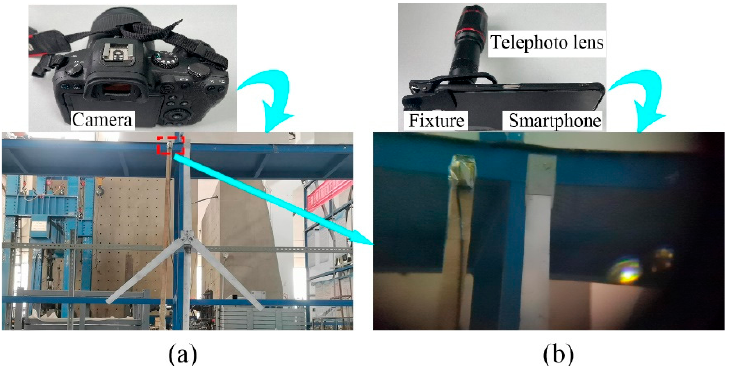
Figure 18. Comparison between camera shooting and smartphone equipped telephoto lens shooting: ( a ) Camera; ( b ) Smartphone equipped with telephoto lens.